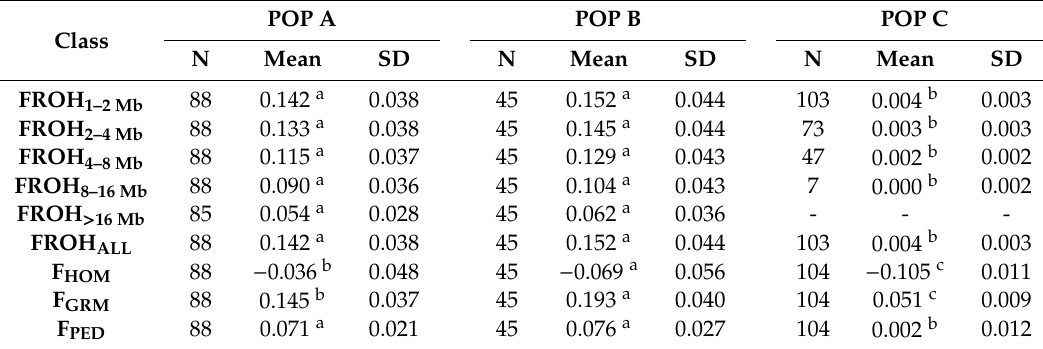
Table 2. The number of individuals (N), mean and standard deviation (SD) of inbreeding coe ffi cients using runs of homozygosity (FROH) for di ff erent ROH length, based on the excess of homozygosity (F HOM ), genomic relationship matrix (F GRM ) and pedigree-based relationship matrix (F PED ) for each coho salmon population.